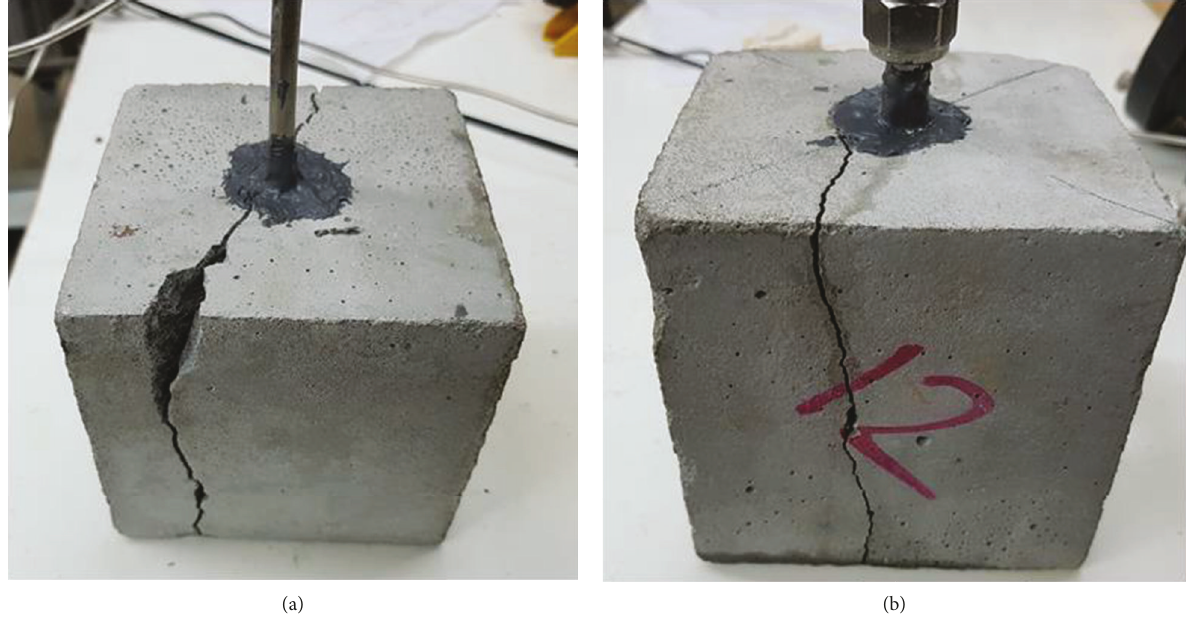
Figure 13: A view of cement blocks after fracturing with thermochemical: (a) cement specimen with 1/4-inch borehole diameter and (b) cement specimen with 3/8-inch hole diameter.